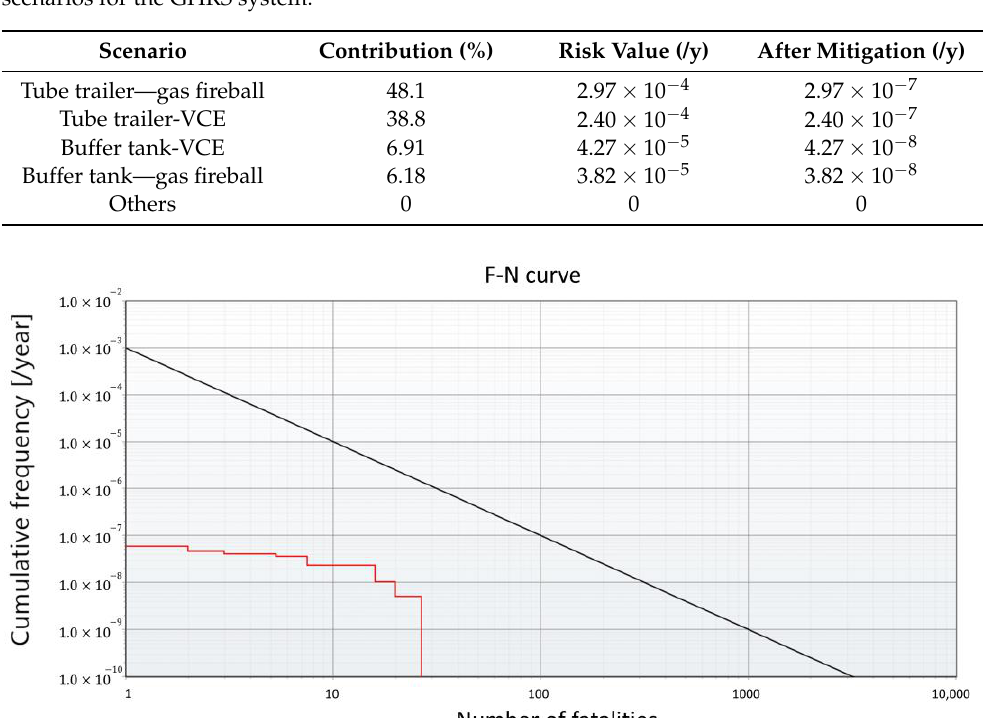
Table 6. The risk values before and after applying safety mitigation measures with respect to the scenarios for the GHRS system.